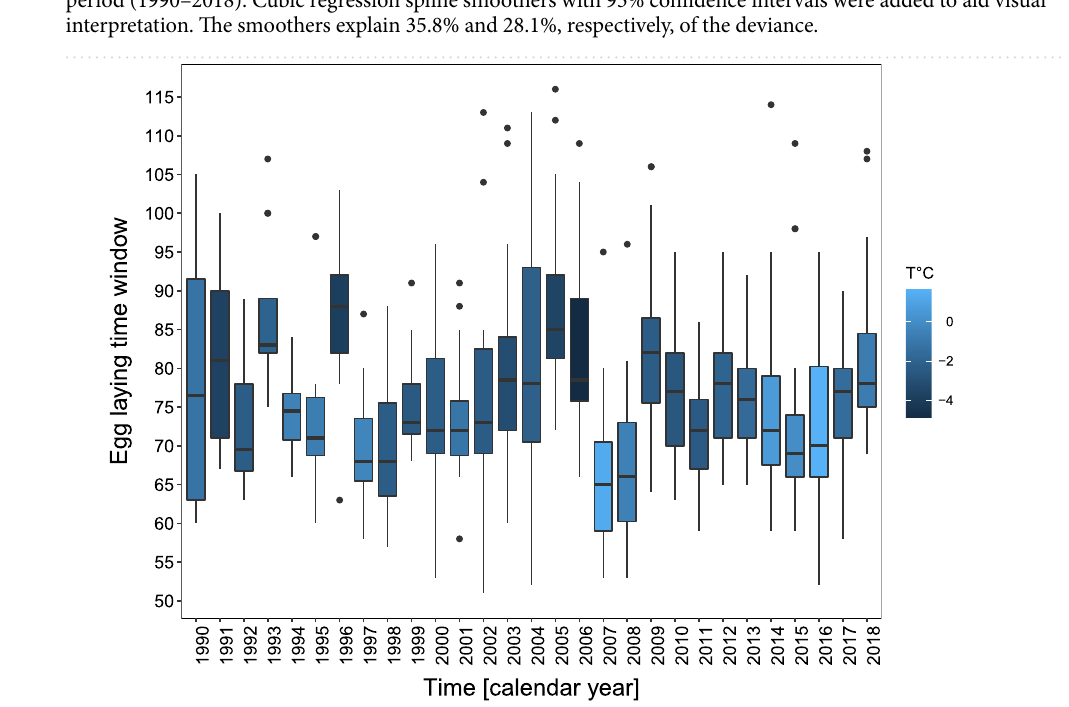
Figure 2. Egg-laying time period (1st quartile, median, 3rd quartile, minimum and maximum) between 1990 to 2018 in relation to average winter temperature (Dec–Feb) in greylag geese in the Alm Valley,